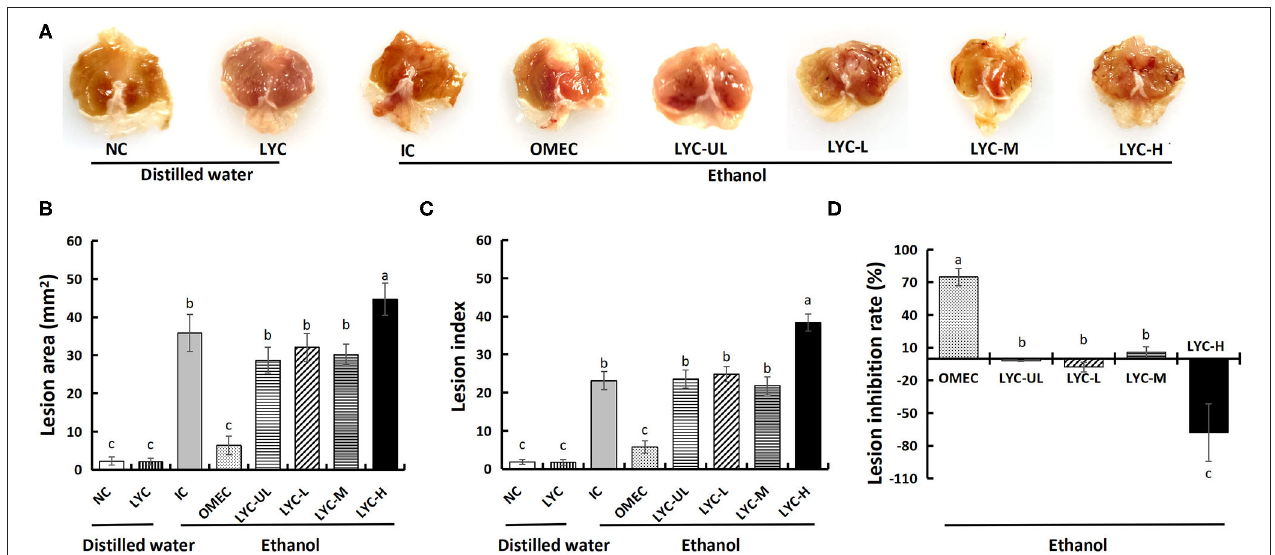
FIGURE 1 | Effect of lycopene on the ethanol-induced gastric lesions in mice. (A) Macroscopic appearance of gastric mucosa. NC, normal control; LYC, lycopene control group, 100 mg/kg bw of lycopene; IC, injury control group; OMEC, omeprazole control group, 20 mg/kg bw of omeprazole; LYC-UL, ultralow-dose group, 10 mg/kg bw of lycopene; LYC-L, lycopene low-dose group, 50 mg/kg bw of lycopene; LYC-M, lycopene medium-dose group, 100 mg/kg bw of lycopene; LYC-H, lycopene high dose group, 150 mg/kg bw of lycopene. NC and LYC groups were perfused with distilled water; IC, OMEC, LYC-UL, LYC-L, LYC-M, and LYC-H groups were perfused with 6.67 ml/kg absolute ethanol. (B) Gross lesion area. (C) Lesion index. (D) Lesion inhibition rate. Different letters (a–c) indicate significant differences ( P < 0.05) between different